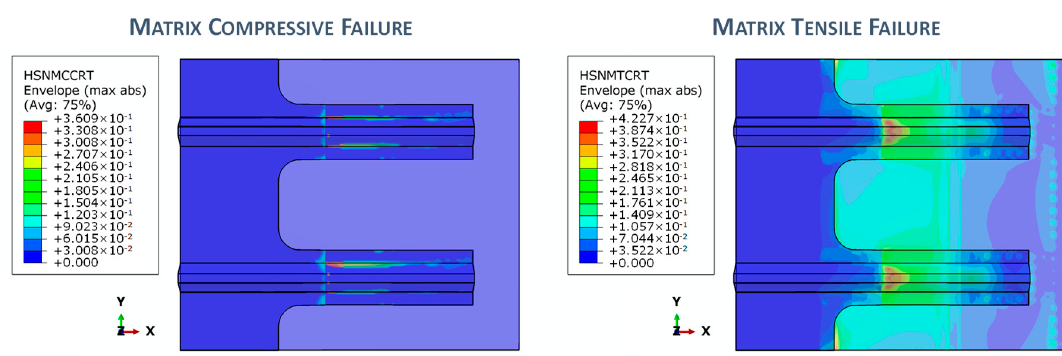
Figure 22. Hashin’s failure criteria: matrix.